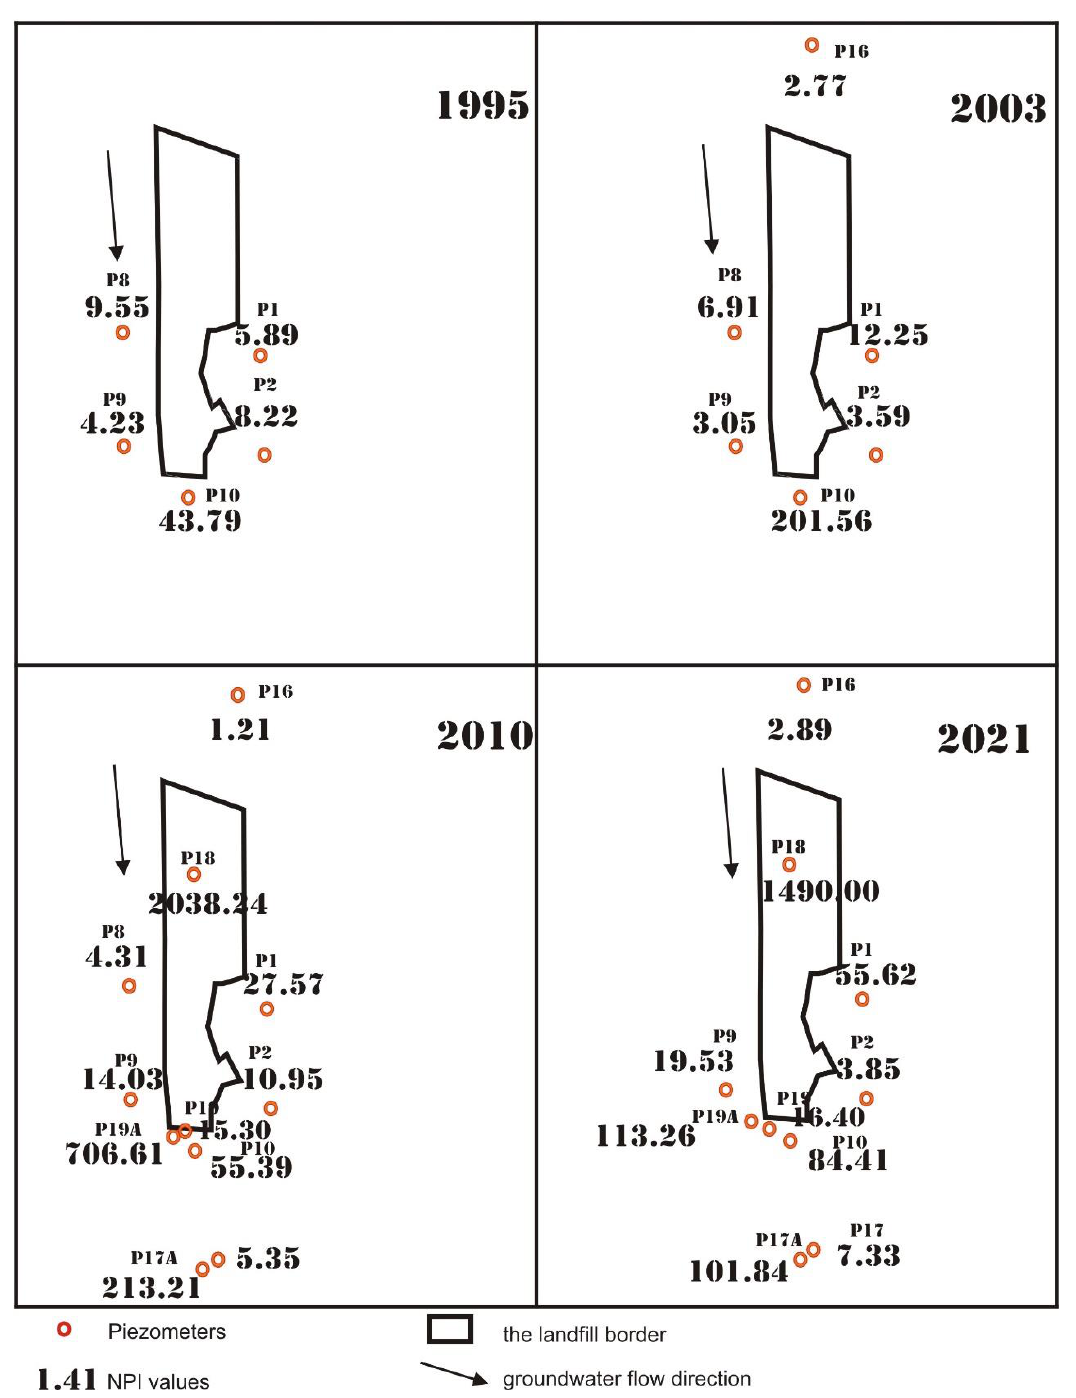
Figure 5. Nemerow Pollution Index values in 1995, 2003, 2010, and 2021.